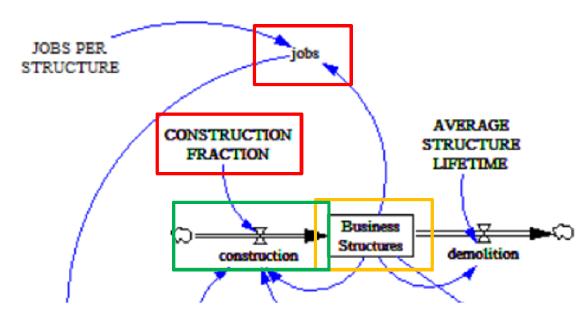
Figure 1: Components of Vensim model (Level in yellow, rate in green, arrows in blue and variables in